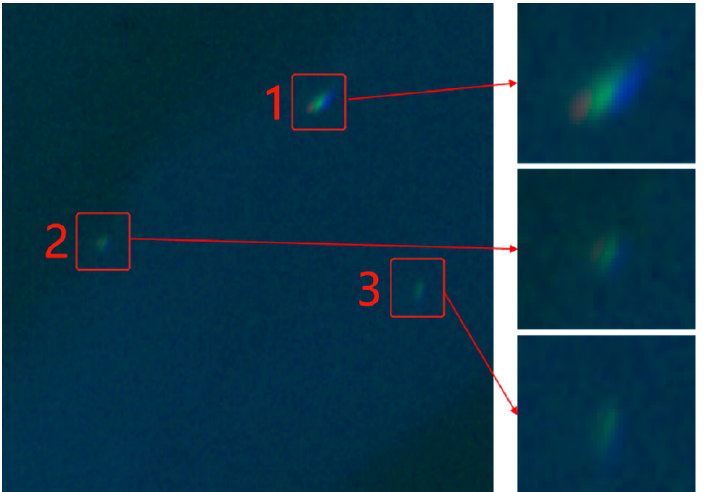
Figure 6. The displacement of moving ships’ positions across multispectral images. The displacement distances of ships in three red boxes vary depending on their velocities.